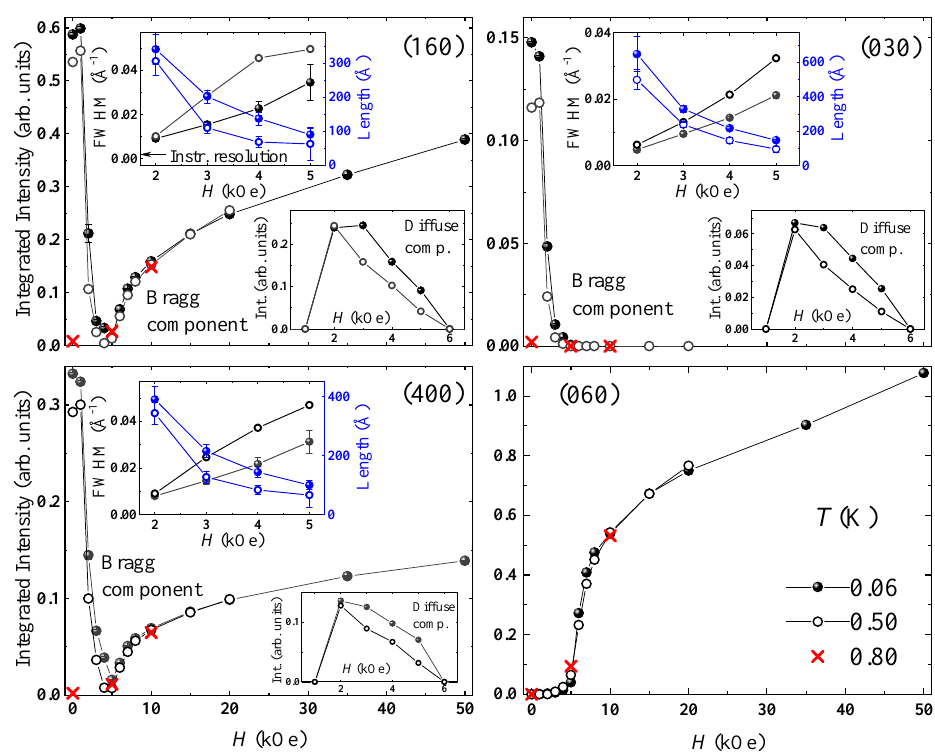
Figure 6: Main panels – field dependence of the integrated intensity of the sharp resolution-limited component of the four magnetic peaks, (160), (030), (400) and (060), for H (cid:107) c . The lower insets show the intensity of the broad magnetic diffuse scattering components as a function on an applied field, while the upper insets show the field variation of the width of these components and the associated correlation length. While the integrated intensity is shown in arbitrary units, the same manip- ulation procedures have been applied to all four reflections, making them directly